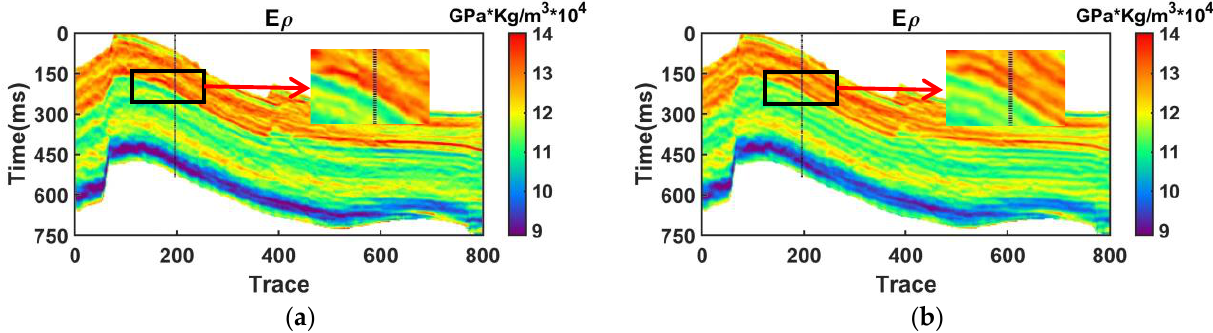
Figure 28. E inversion results based on (a) traditional method and (b) reweighted Lp method.